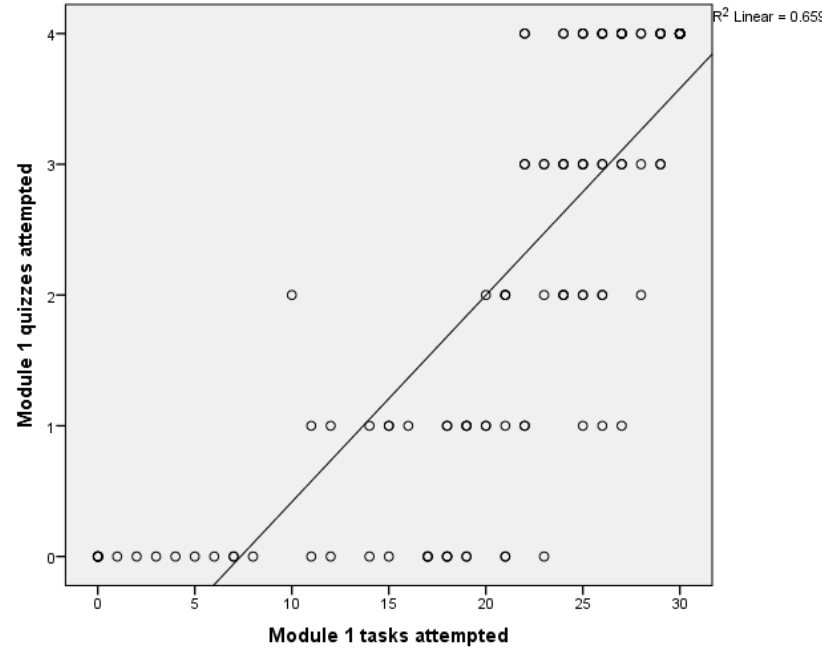
Figure 7: Scatterplot of correlation between task and quiz completion, Module 1 A positive correlation was also found in relation to the number of knowledge check quizzes and the number of tasks completed in Module 2, and the correlation was found to be statistically significant (p < 0.001, r = 0.810).